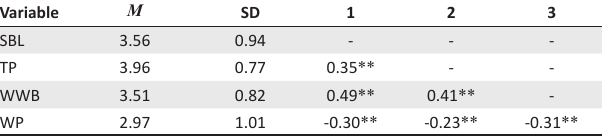
TABLE 2: Descriptive statistics and correlation between variables.